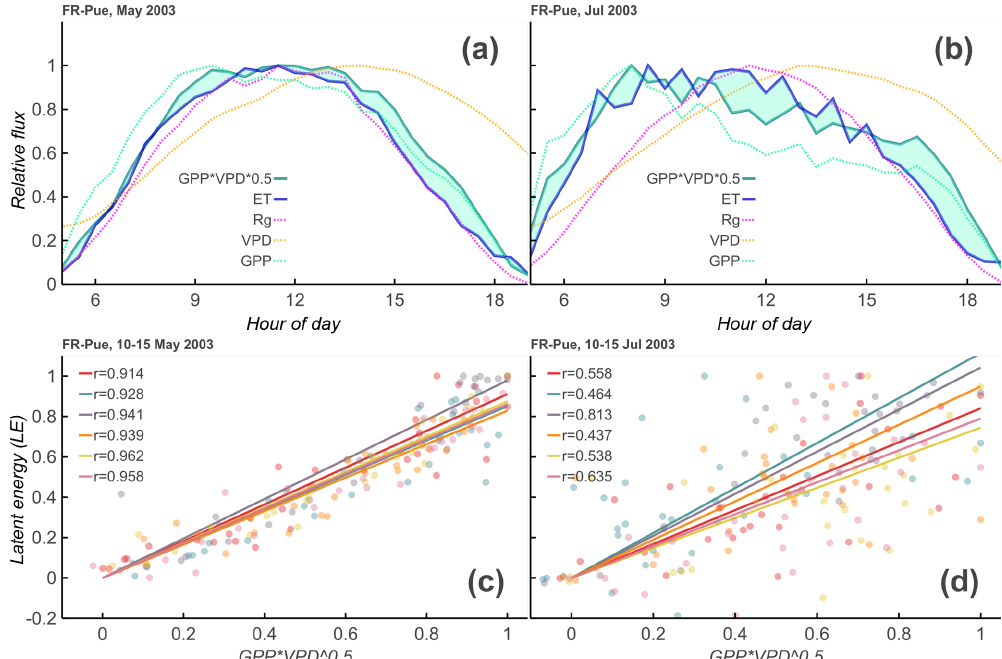
Figure 2. Theoretical overview of Diurnal Water–Carbon Index. Panels (a) and (b) : 1-month average diurnal cycle of incoming shortwave radiation ( R g ), evapotranspiration (ET), vapor pressure deficit (VPD), gross primary productivity (GPP), and GPP · VPD − 0 . 5 at the Puéchabon Forest, France (FR-Pue), site during 2003. Discrepancies between GPP · VPD − 0 . 5 and ET increase from the relatively wet May (32mm rainfall, a, c ) to the relatively dry July (0mm rainfall, b, d ). Panels (c) and (d) : these discrepancies are reflected in the daily correlation values between GPP · VPD − 0 . 5 and ET, giving an indication of the appropriateness of the uWUE model for each day, as well as the degree of coupling between water and carbon